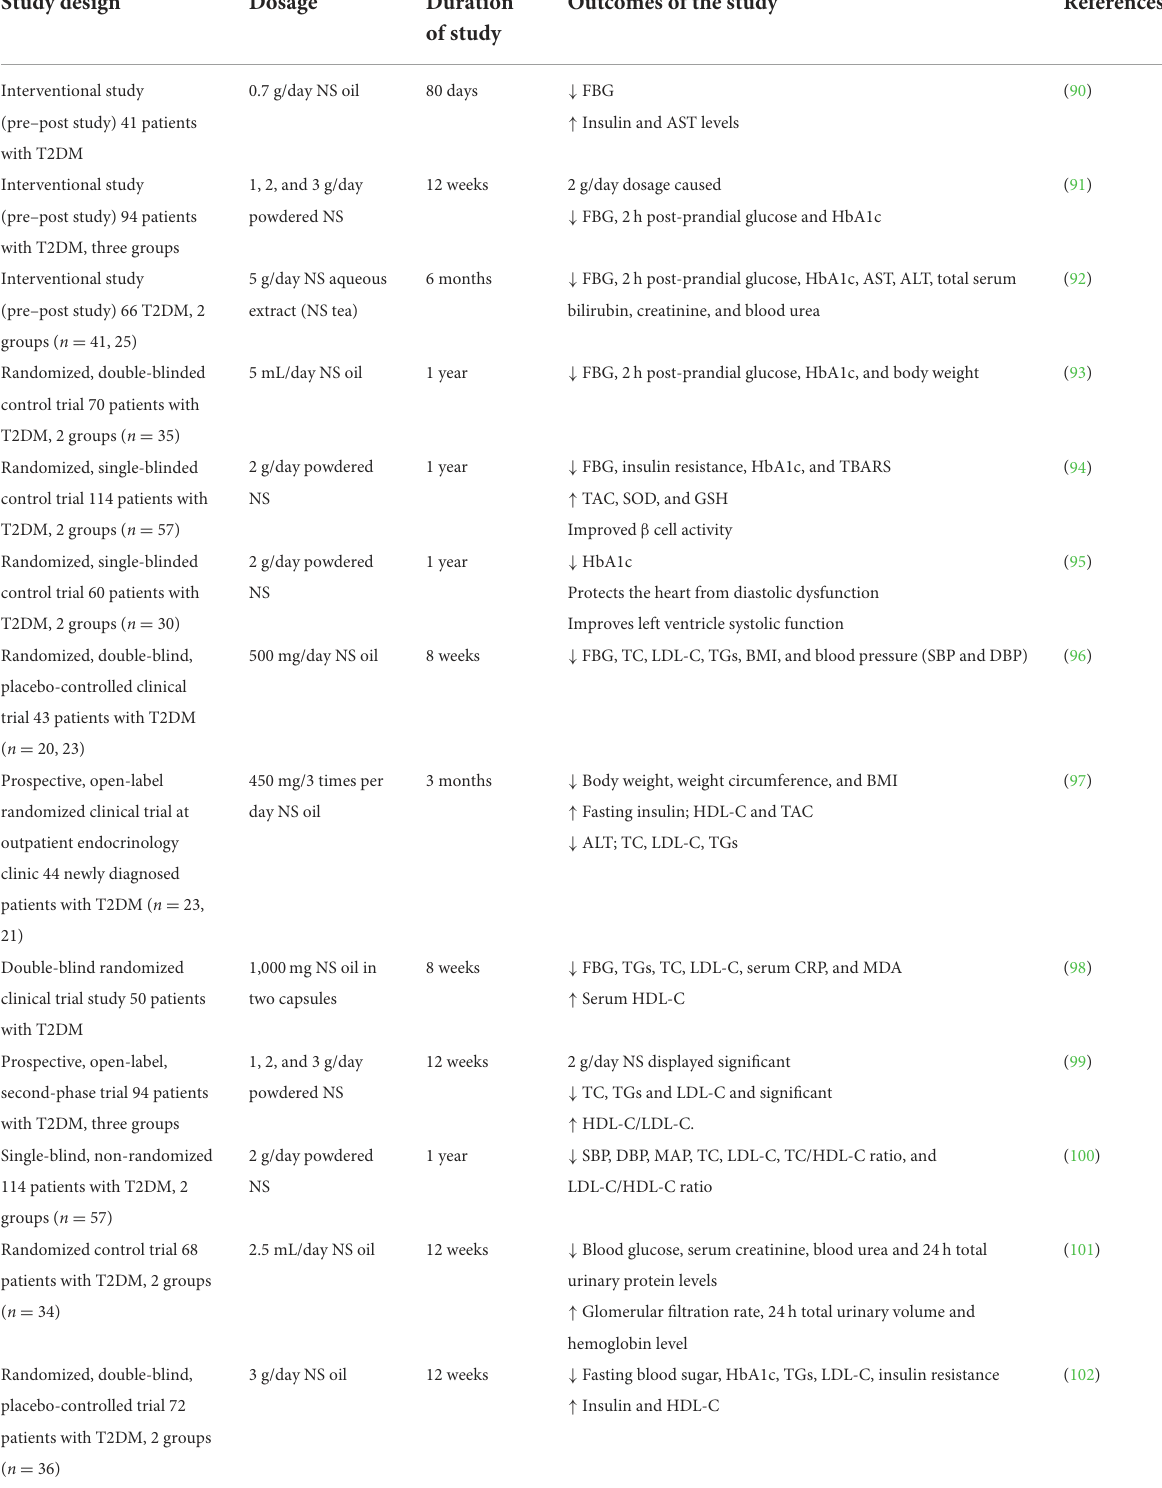
TABLE 3 Summary of NS’s effects on DM from clinical